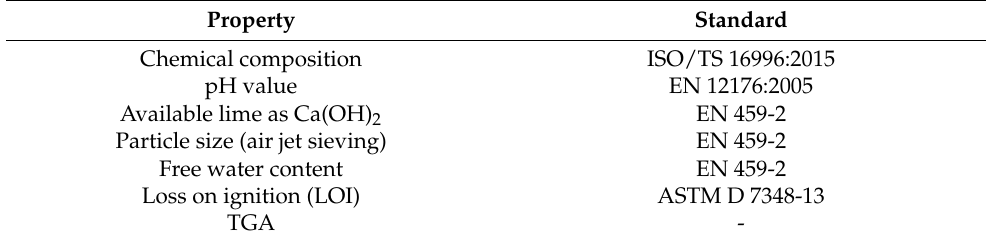
Table 3. Test methods for characterization of wood biomass ash (WBA) and coal fly ash (CFA).